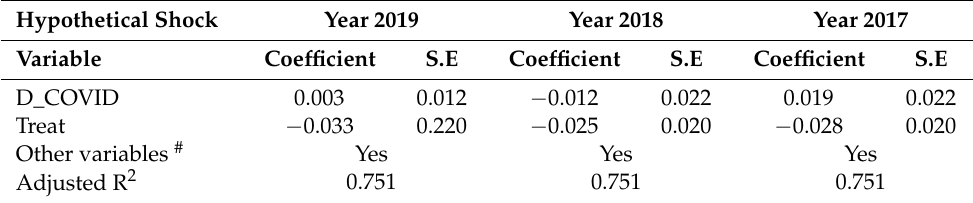
Table 5. Falsification test of the DiD